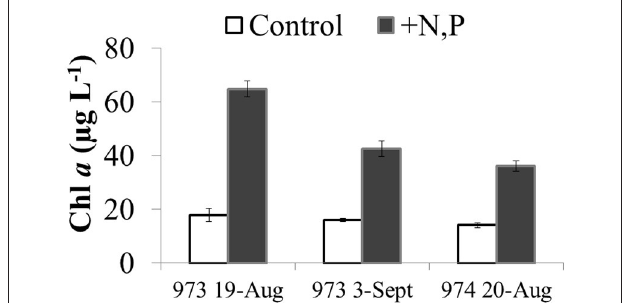
FIGURE 14 | Chlorophyll a concentrations at the end of the microcosm experiments ( t = 48 h) using Lake Erie water from the western basin (sites 973 and 974) in August and September 2014. Chlorophyll a in control (unamended lake water) is compared to the same water amended with N and